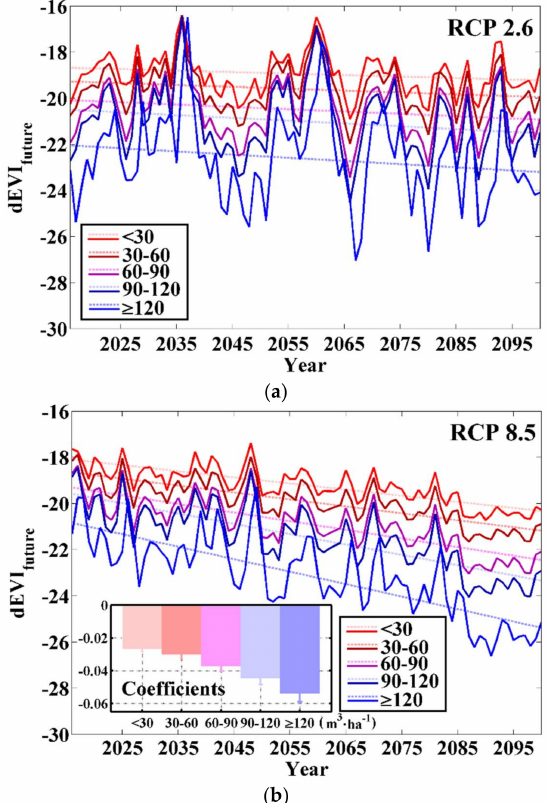
Figure 7. Changes in annual average dEVI future of forests under two future climate scenarios. ( a ) RCP 2.6; and ( b ) RCP